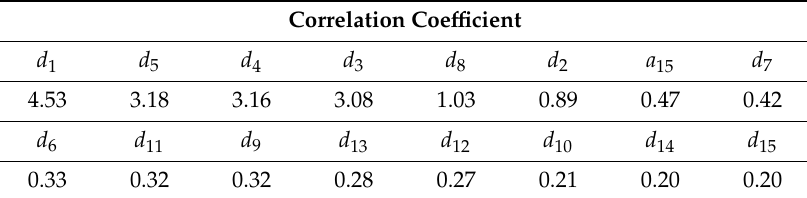
Table 3. The correlation of each feature.